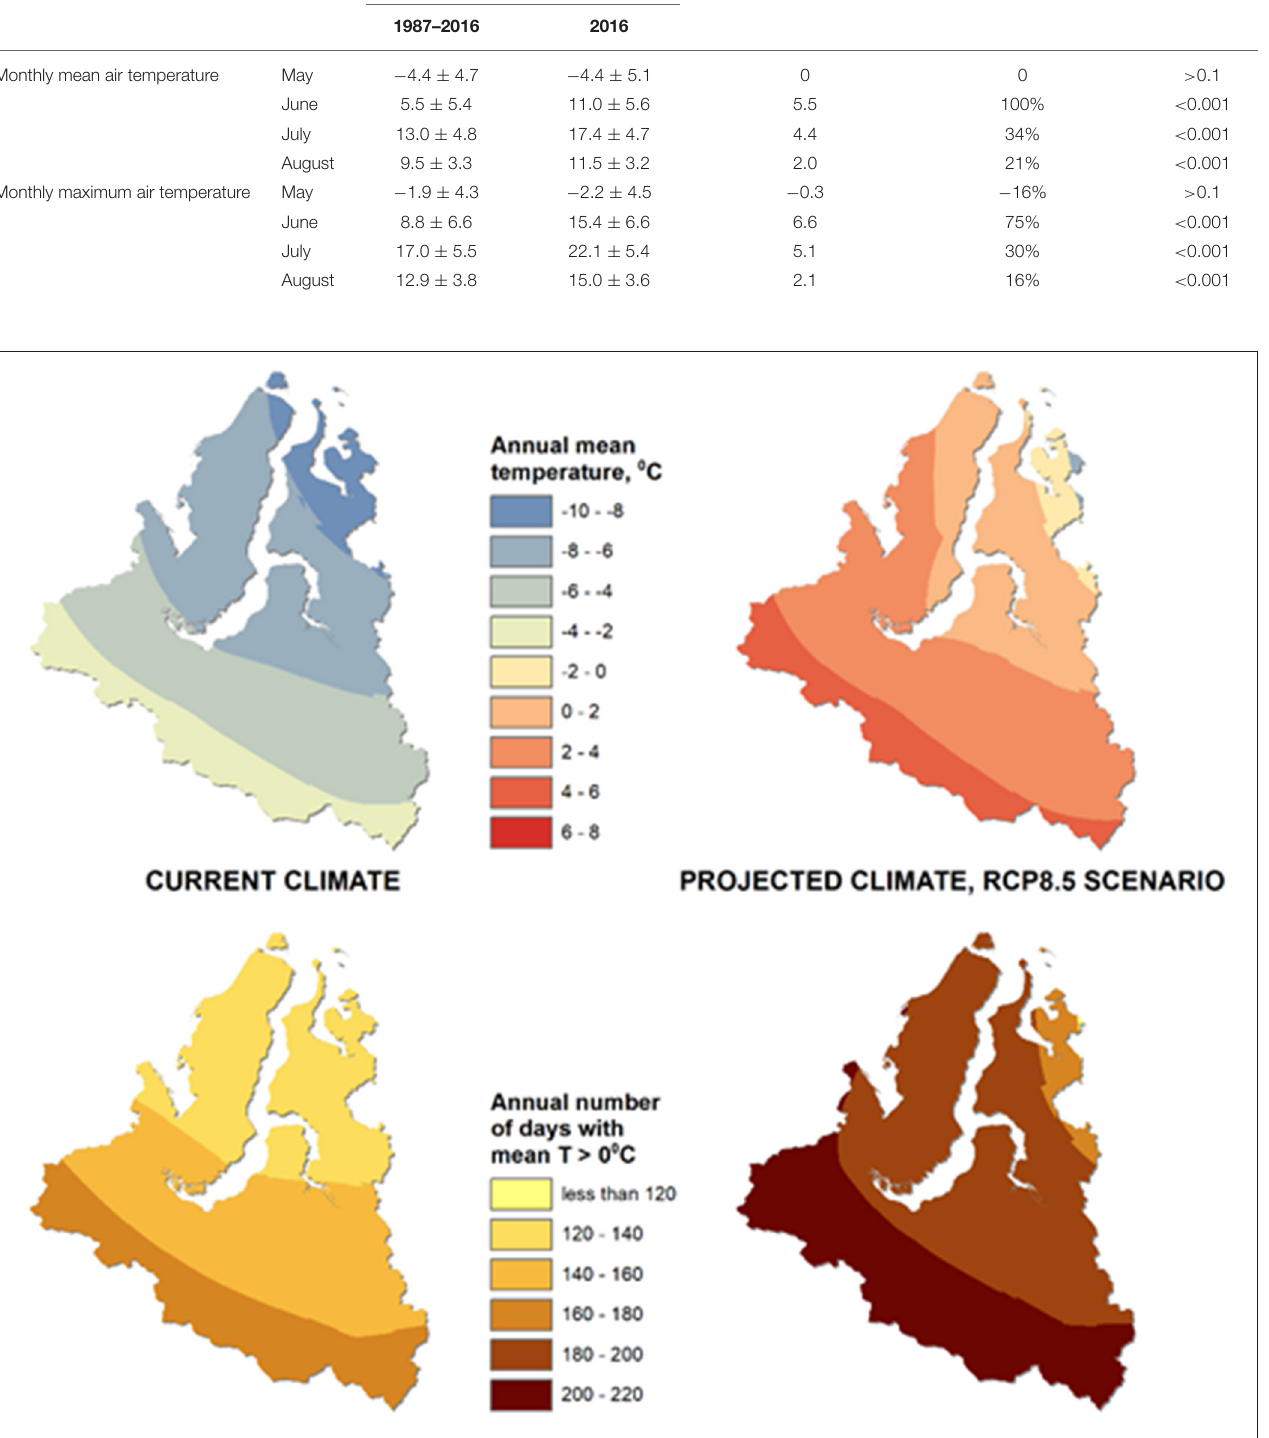
Frontiers in Veterinary Science | www.frontiersin.org